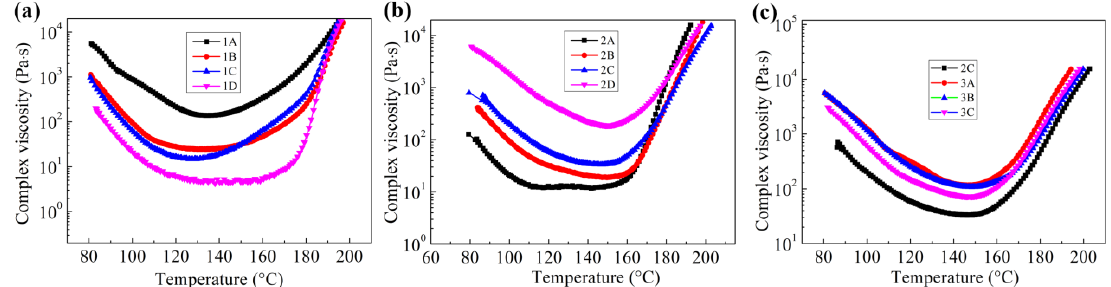
Figure 3. Rheological properties of different modified BMI adhesives: ( a ) Viscosity curves of epoxy- modified BMI resin as a function of temperature; ( b ) Viscosity curves of PEK-C-toughened epoxy- modified BMI resin as a function of temperature; and ( c ) Viscosity curves of PEK-C/core–shell polymer co-toughened epoxy-modified BMI resin as a function of temperature.